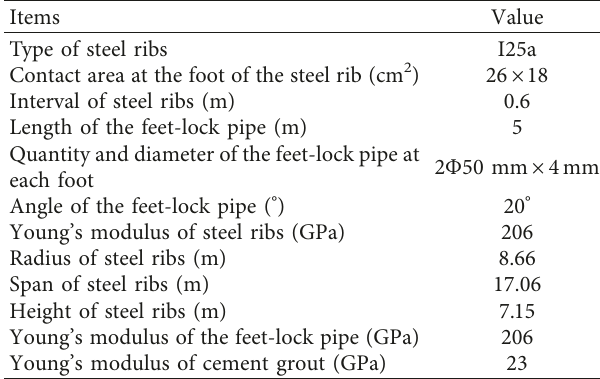
Table 6: Basic parameters for excavation and support of the